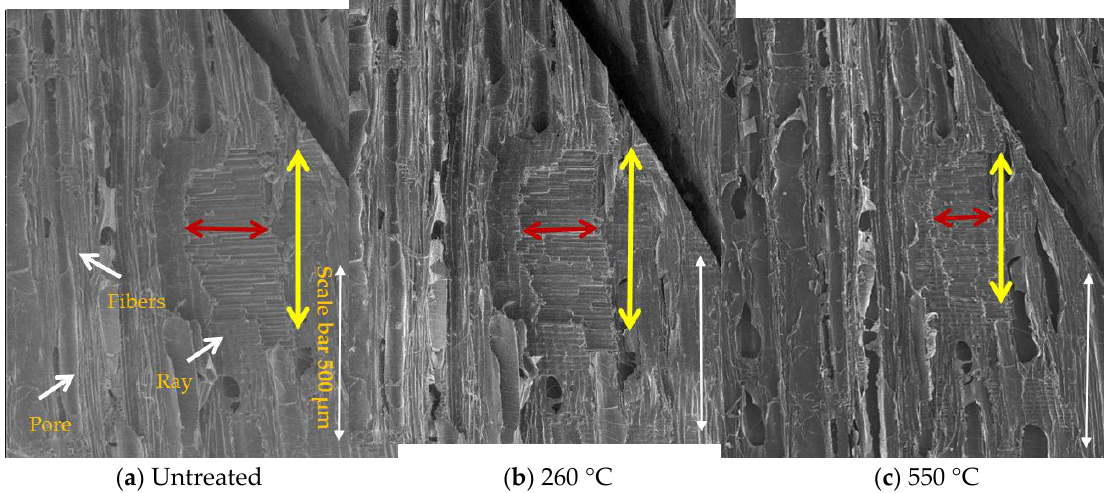
Figure 7. SEM images (horizontal field width = 1.28 mm; scale bar of 500 µm; vertical as images are presented) of the radial section views of the untreated and the 300 and 550 °C treated cherry wood samples. White arrows point out fibers and rays that look like a brick wall crossing in the longitudinal direction, also pores are visible in the radial section images. Yellow bars mark shrinkage along the axial direction (using reference structures). Red bars mark shrinkage along the radial direction (using reference structures).